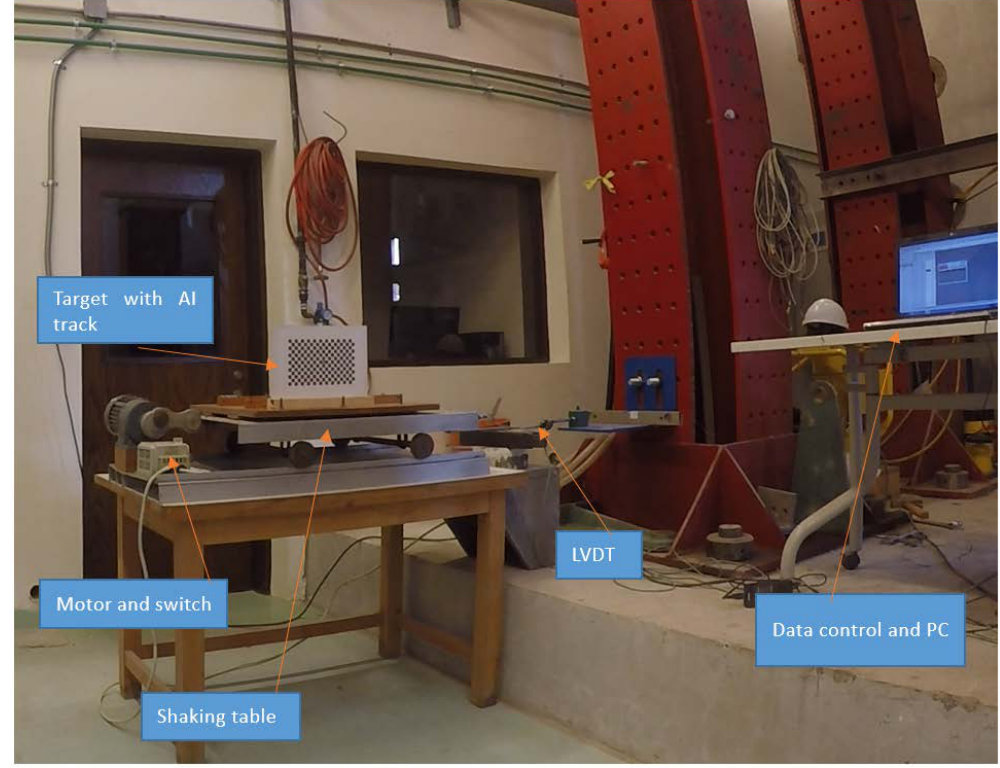
Figure 8. Monitoring of shaking table oscillations test setup.